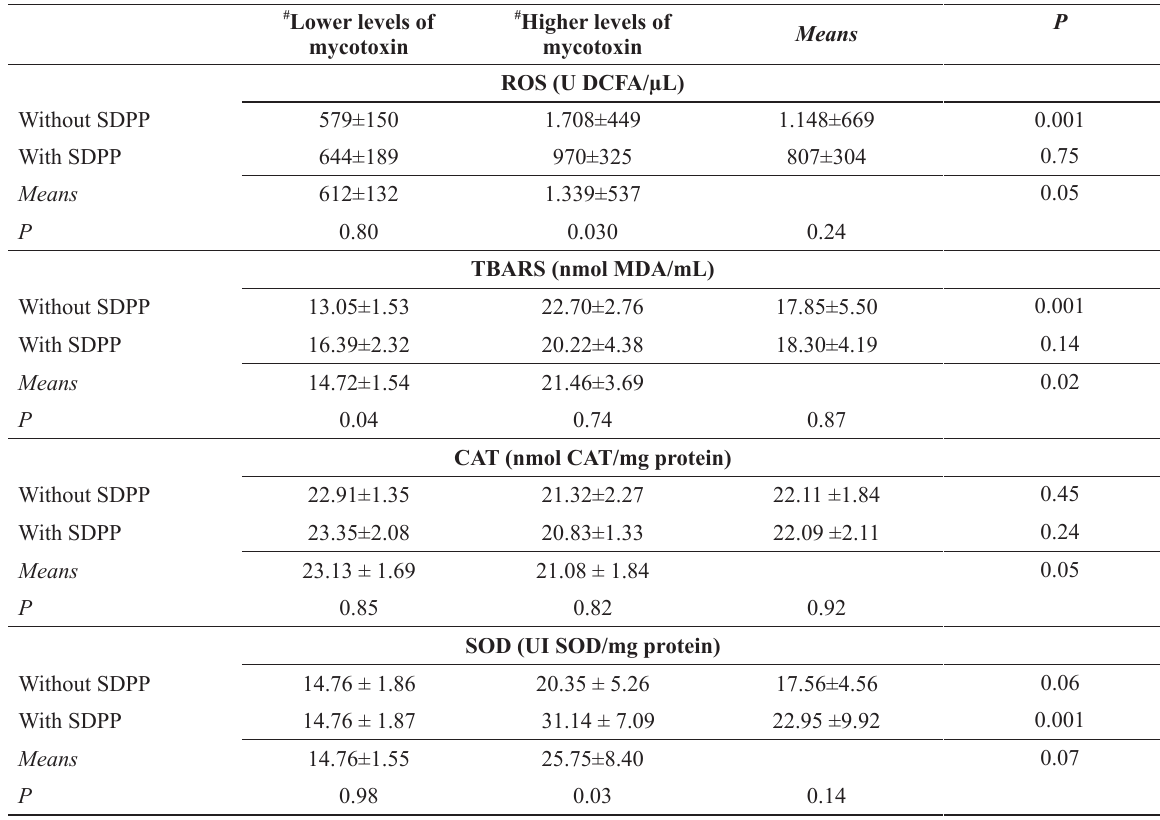
Results of reactive oxygen species analysis (ROS), thiobarbituric acid reactive species (TBARS), catalase (CAT) and superoxide dismutase (SOD) in the liver of piglets fed with mycotoxin diet and supplemented with spray-dried porcine plasma